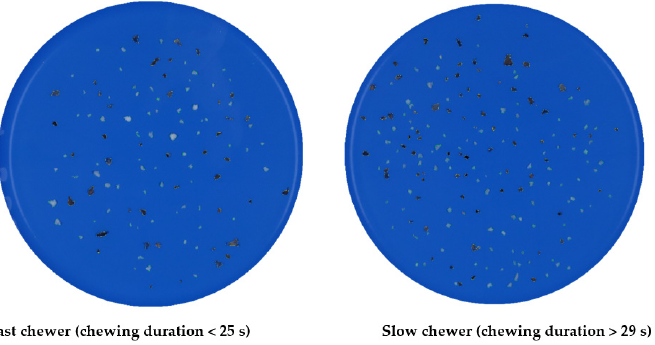
Figure 4. Example of processed image of black beans after mastication by a fast chewer and a slow chewer. Table 1. Estimated Rosin-Rammler parameters (Equation (2)) of “all” black bean particles from samples A (PEF and thermally processed without CaCl 2 addition), B (PEF and thermally processed